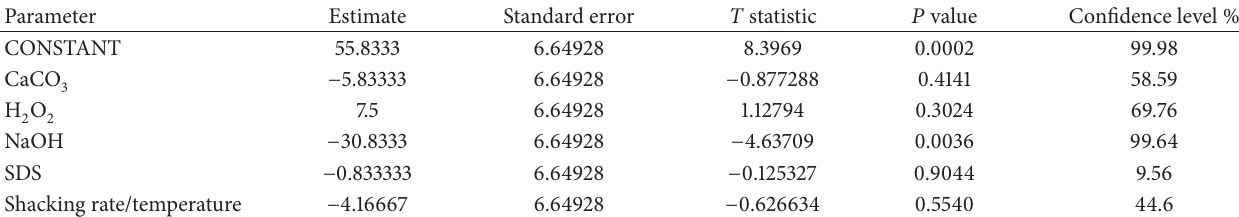
Table 3: Linear multiple regression analysis of Plackett-Burman.